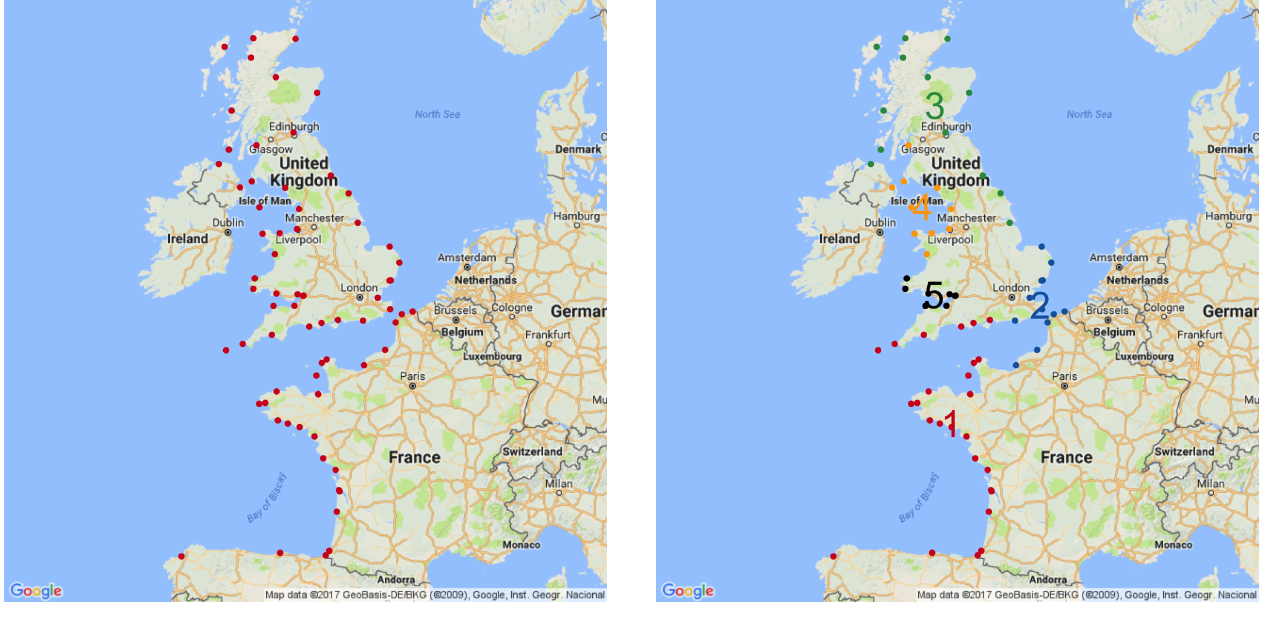
Figure 4. Location of the 71 tide gauges used in this study. Figure 5. The five physically and statistically homogeneous regions of the 71 tide